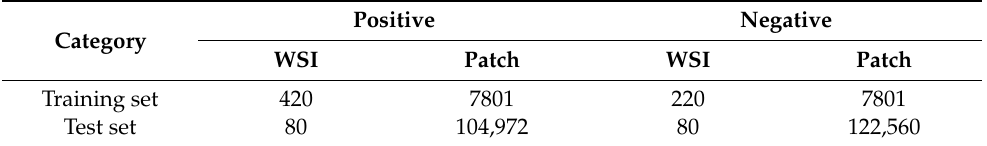
Figure 4. A zoomed display of an example set of the labeled cervical cells. ( A ) Labeled negative cells (normal), ( B ) labeled positive cells (cancerous). Table 2. The number of WSIs and cropped patches for the training and test datasets.